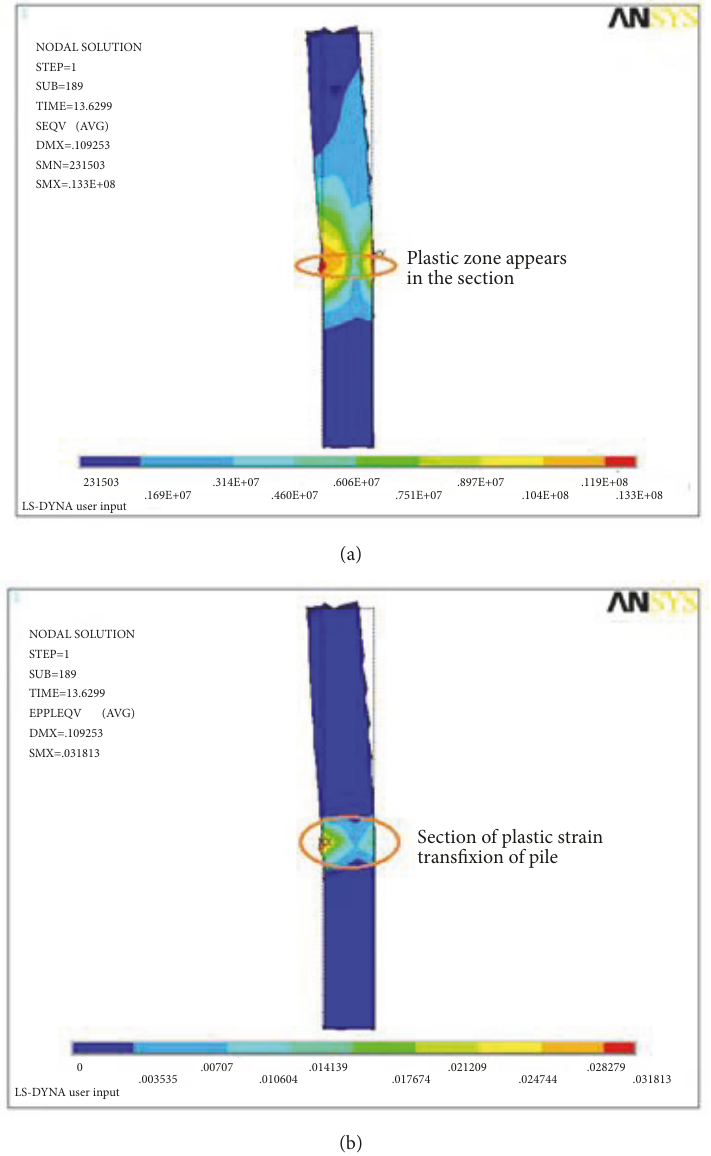
Figure 16: The plastic strain cloud diagram of stabilizing pile under the action of seismic force. (a) Equivalent stress; (b) plastic strain.